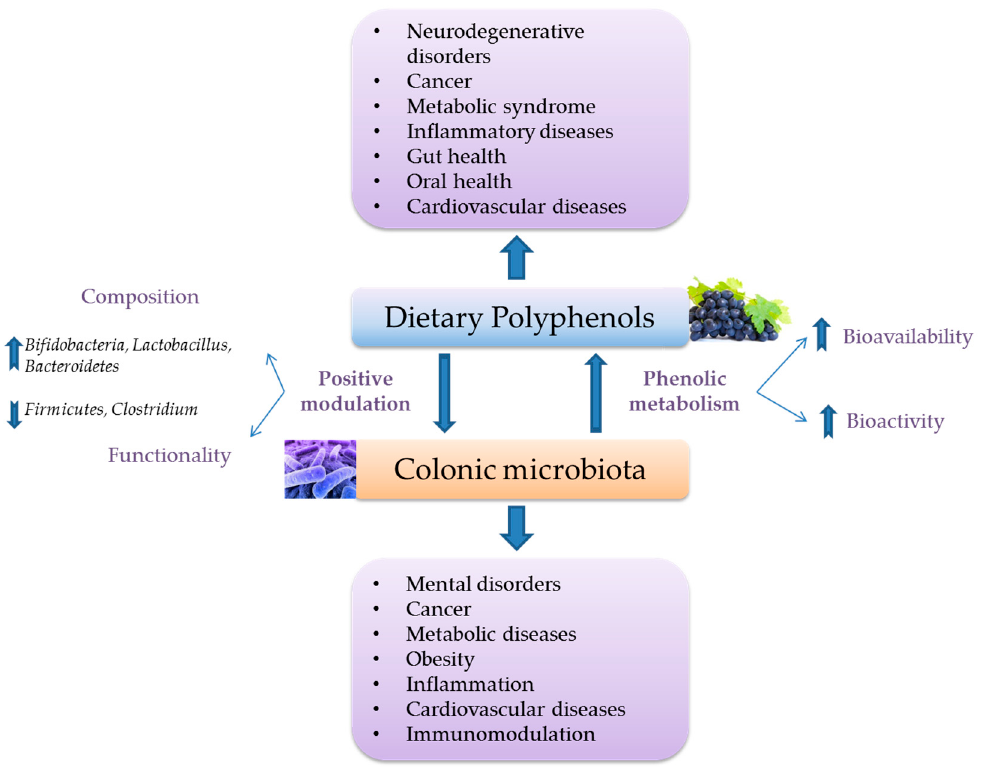
Figure 2. Scheme of the health effects implied from the two-ways interaction between polyphenols and intestinal microbiota.